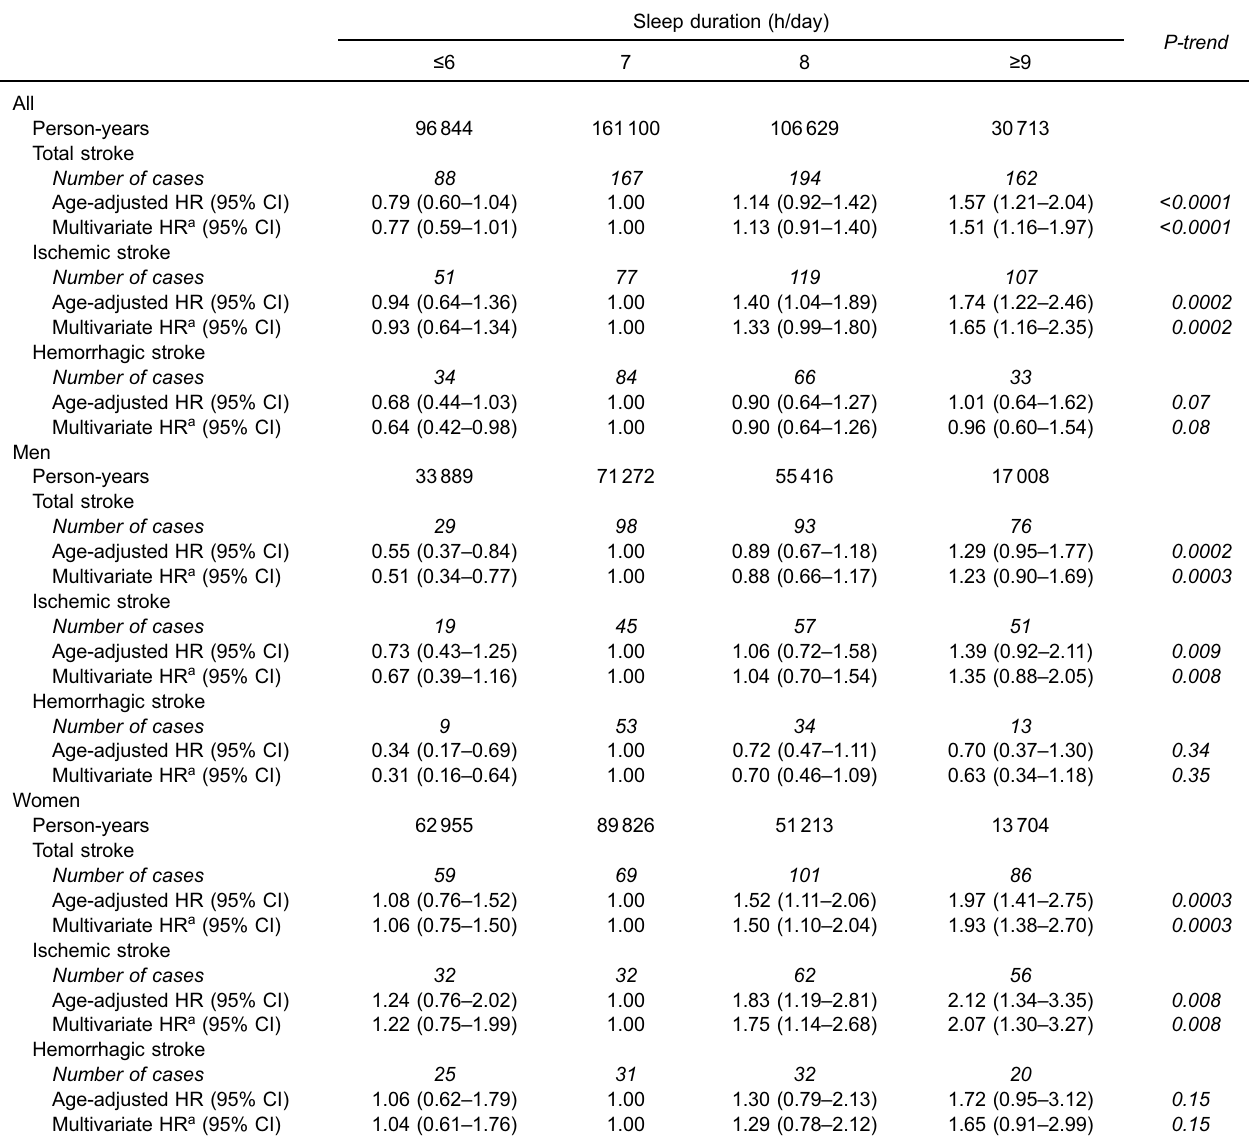
Table 2. Hazard ratios and 95% con fi dence intervals for mortality from stroke according to sleep duration